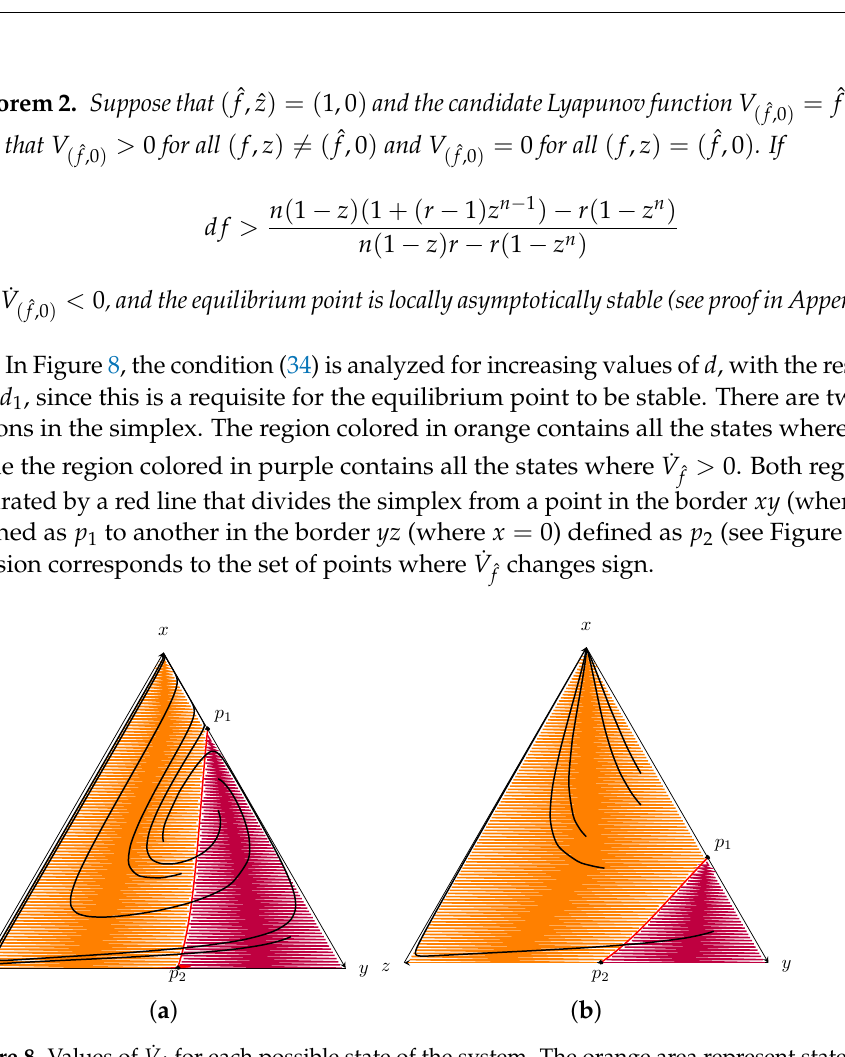
Figure 8. Values of ˙ V ˆ for each possible state of the system. The orange area represent states ˙ V ˆ f > 0. The red line between both regions represent the set of points the purple area represent states ˙ V ˆ f where ˙ V ˆ changes sign. The black lines are trajectories from several initial values in the simplex. f Parameters n = 5, r = 3, and σ = 1, and increasing values of d : ( a ) d = 0.25 and ( b ) d =